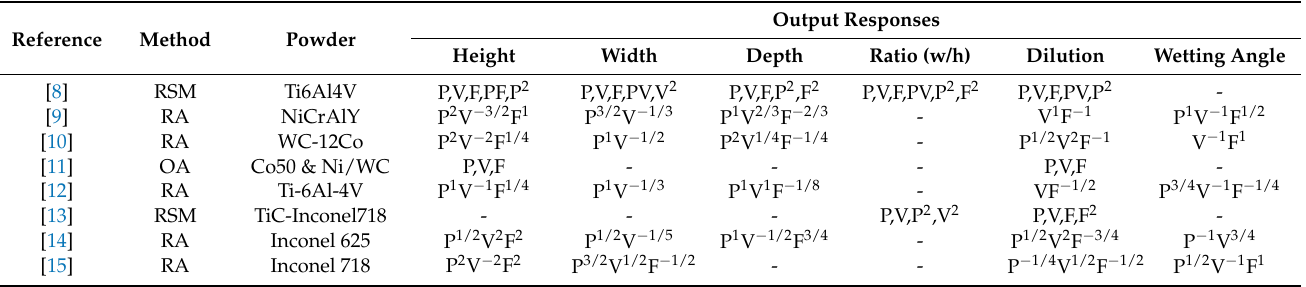
Table 1. Summary of input parameter optimization studies from other scholars.